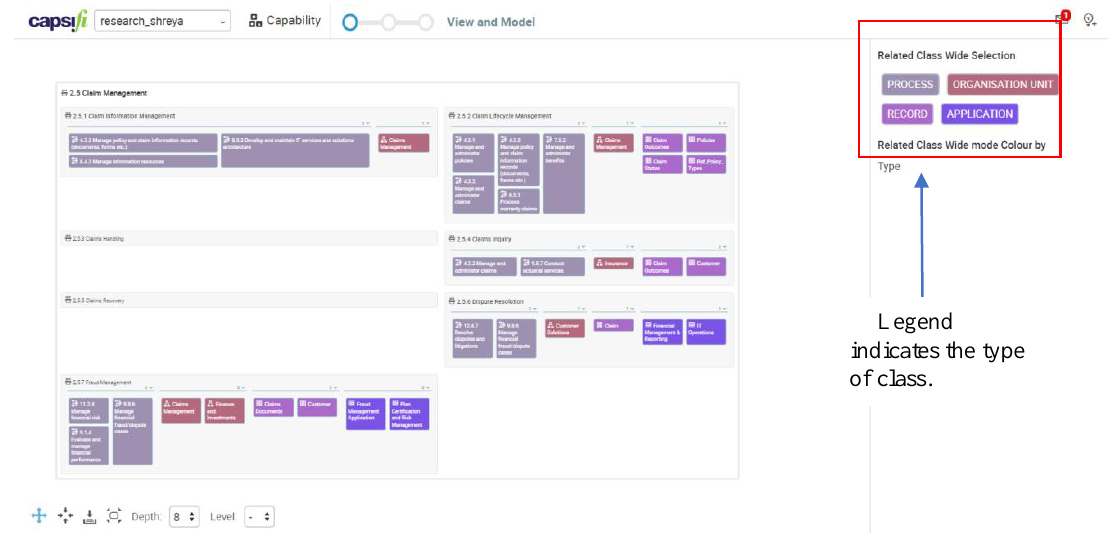
Legend indicates the type of